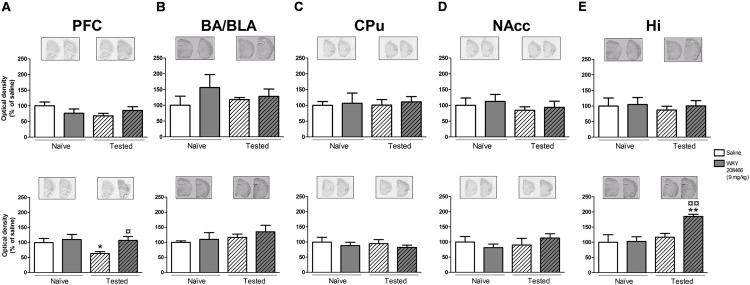
Effects of saline and WAY208466 (9 mg/kg, ip) on the levels of Arc (activity-regulated cytoskeleton-associated protein) mRNA after PA test for STM (upper) or LTM (lower) for (A) PFC, pre frontal cortex; (B) BA/BLA, lateral and basolateral amygdala; (C) CPu, caudate putamen; (D) NAcc, nucleus accumbens; (E) Hi, hippocampus.
∗p < 0.05; ∗∗p < 0.01 compared to saline naïve group. ¤¤p < 0.01 compared to saline group. Mean ± SEM; n = 6–8 mice per group.